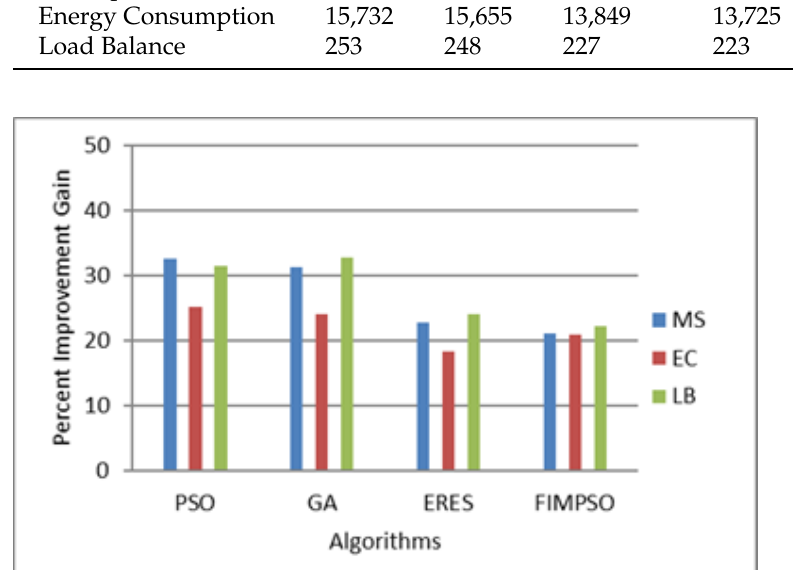
Figure 2. Percent improvement gain of the proposed algorithm over the other methods on the Montage